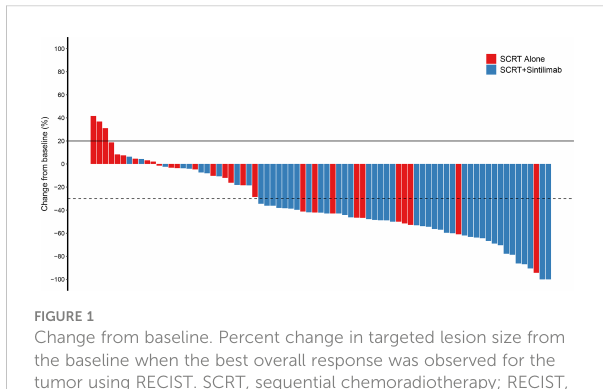
FIGURE 1 Change from baseline. Percent change in targeted lesion size from the baseline when the best overall response was observed for the tumor using RECIST. SCRT, sequential chemoradiotherapy; RECIST, response evaluation criteria in solid tumors.